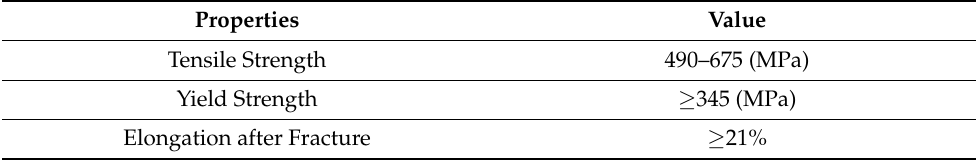
Table 1. Material properties of specimens